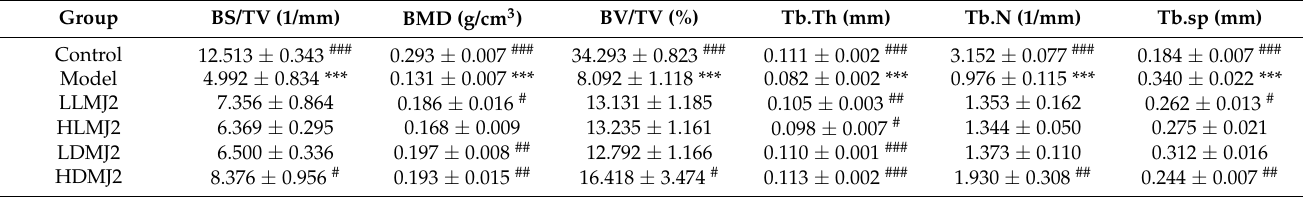
Table 4. Bone parameters in CIA mice measured by micro-CT ( n = 8 per